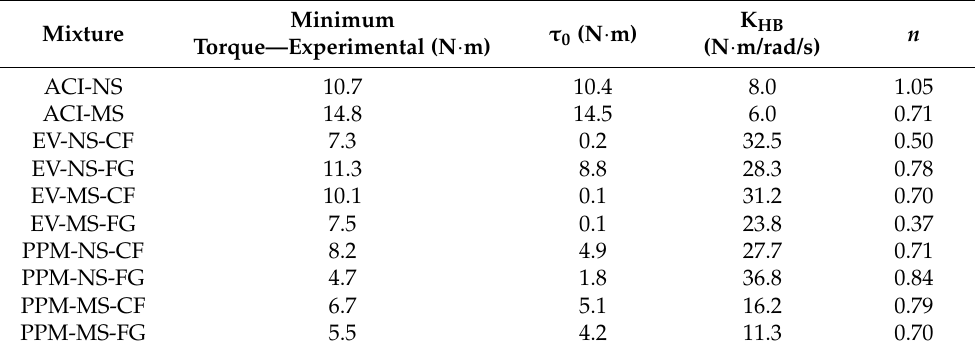
Table 6. Parameters of Herschel–Bukley’s equation and minimum torque required for all mixtures inves-tigated.